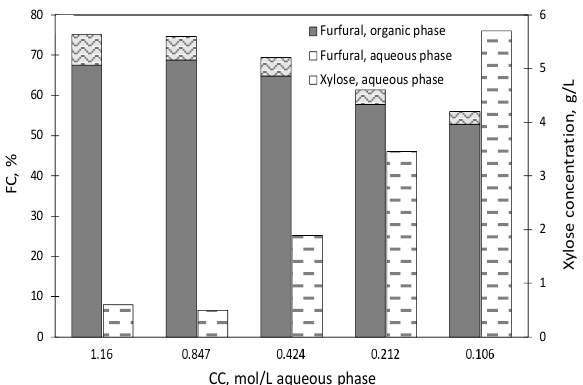
Figure 1. Molar conversions of potential substrates into furfural (FC) and xylose concentrations obtained at 180 °C using [C4mim]HSO 4 as a catalyst.